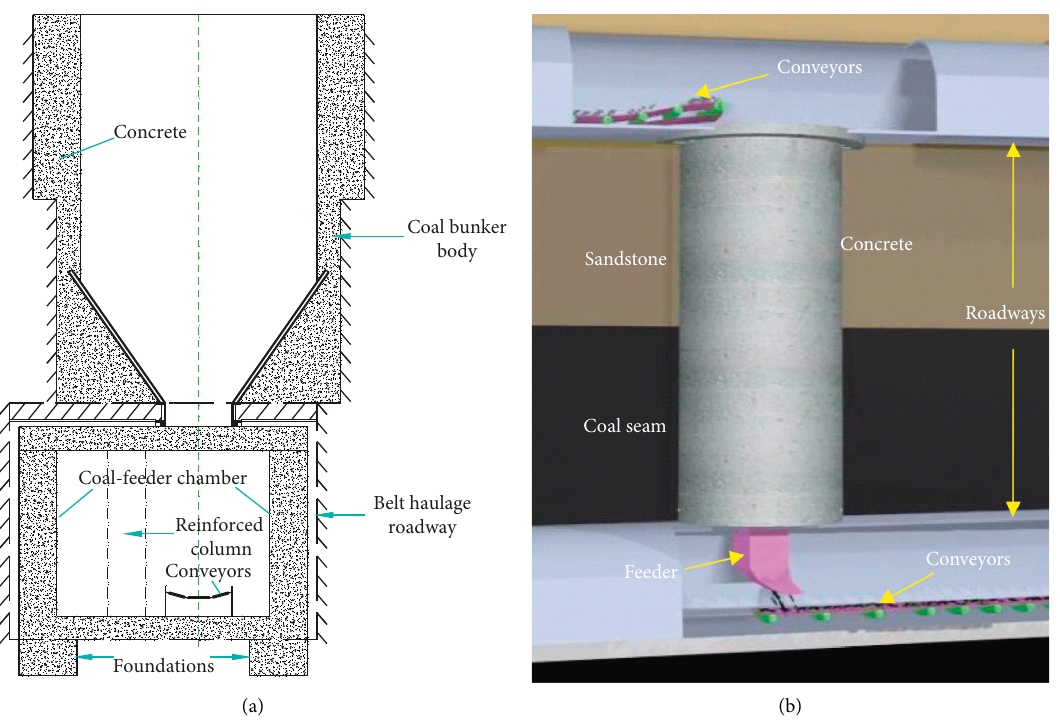
Figure 2: Structure of (a) traditional vertical bunker #214 and (b) the new designed vertical bunker without